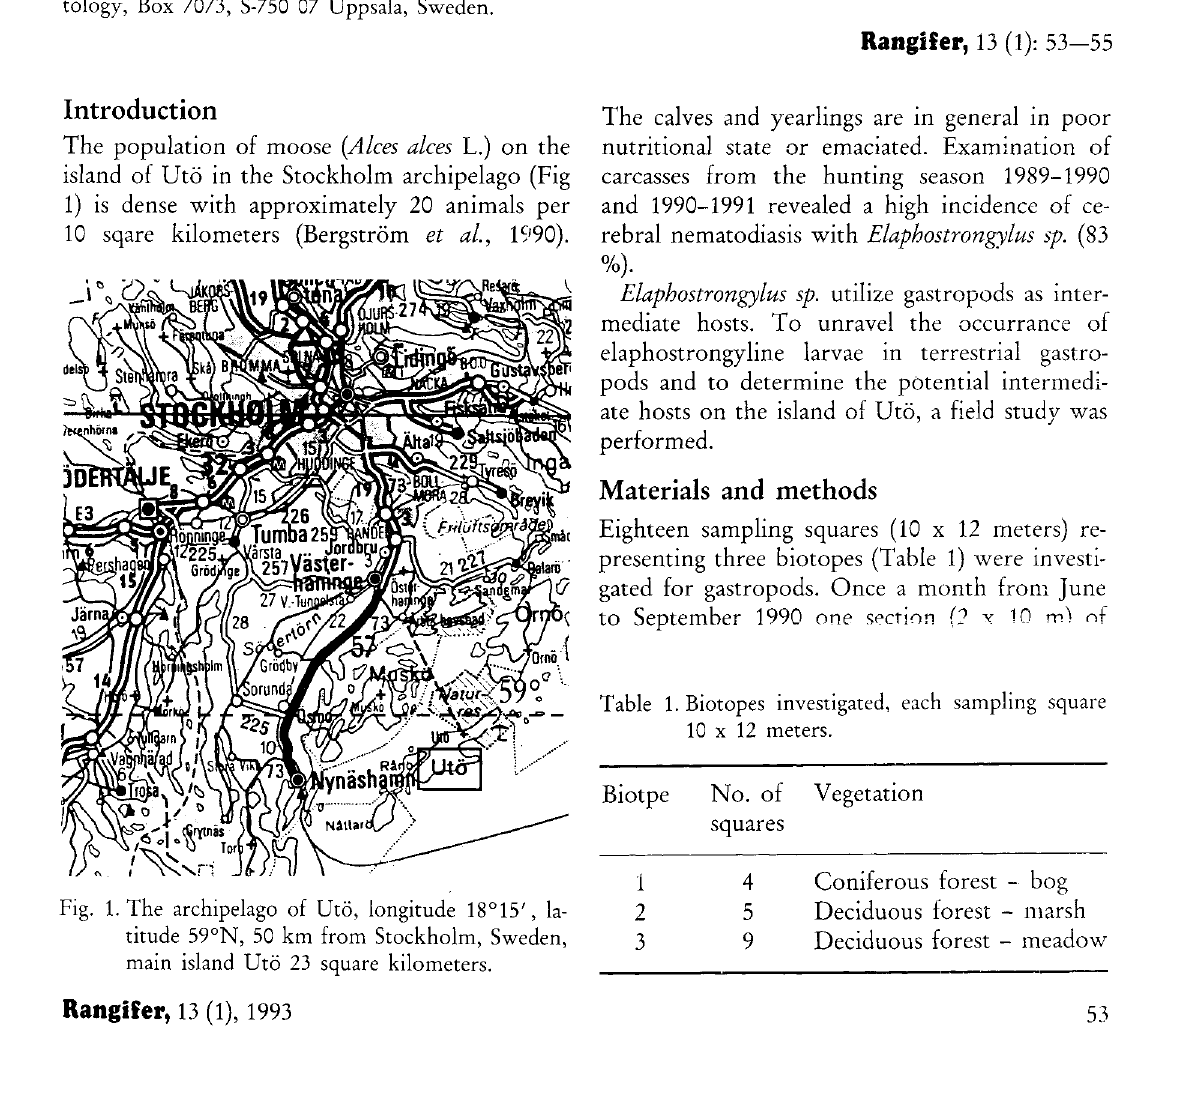
Fig. 1. The archipelago of Utô, longitude 18°15', la titude 59°N, 50 km from Stockholm, Sweden, main island Utô 23 square kilometers.